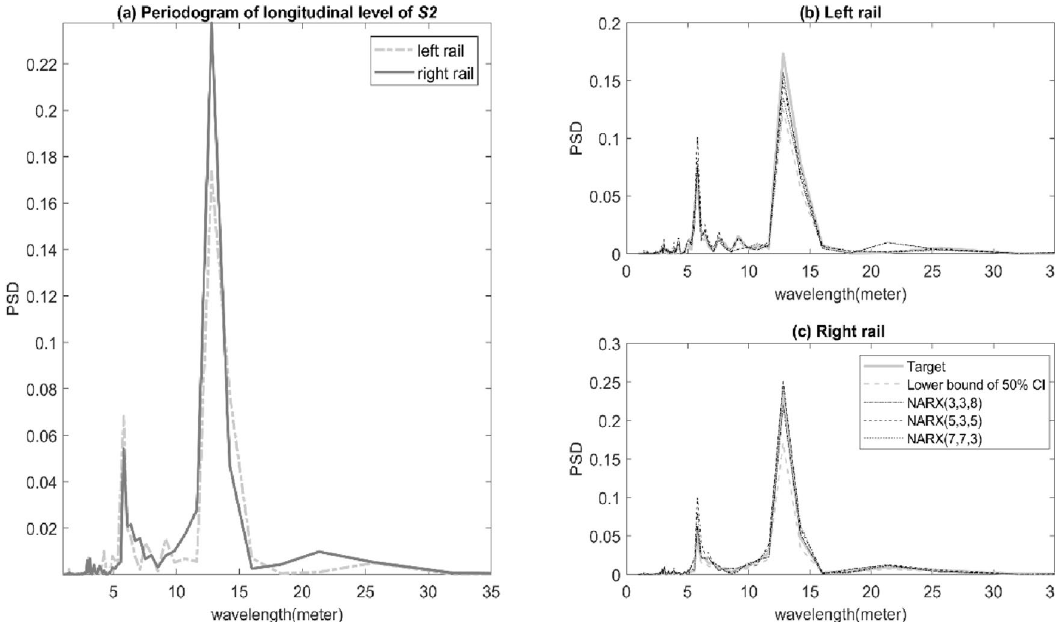
Figure 8. PSD comparisons between ( a ) the left and right rail, and artificial and actual longitudinal track level of ( b ) left rail, and ( c ) right rail for